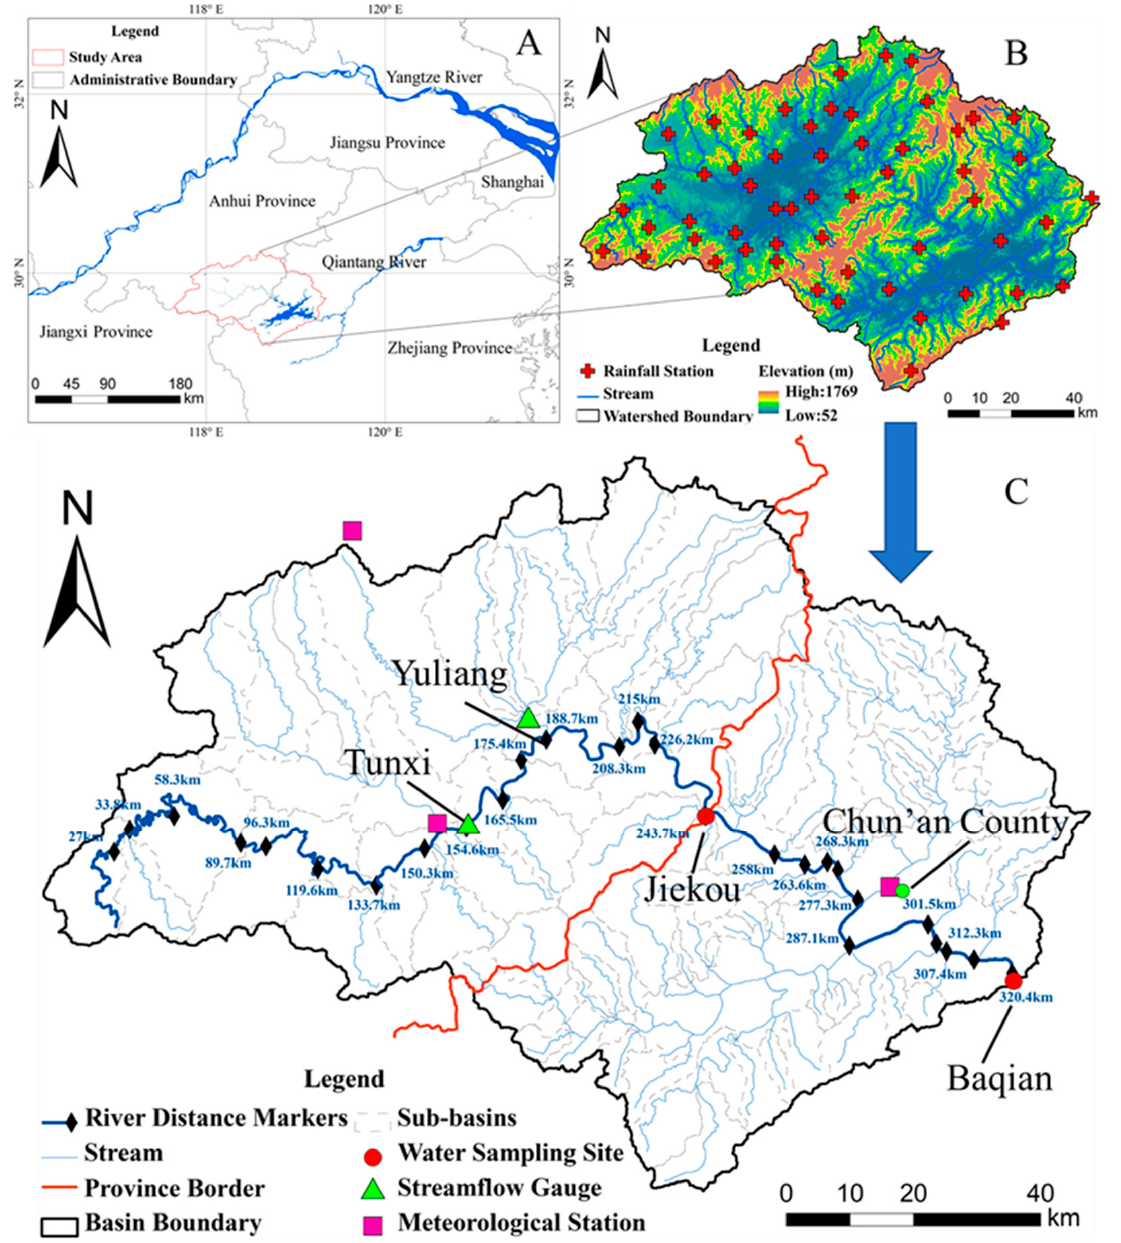
Figure 1. The Qiandao Lake Basin (QLB). ( A ) The Yangtze River delta region showing the orientation of the basin in Anhui and Zhejiang provinces. ( B ) Topography of the basin showing elevations and the location of rainfall stations. ( C ) Detailed map of the basin showing streams, sub-basins, important monitoring sites, and distance markers along the reach of the Xin’anjiang River. The location of the urban core of Chun’an County is also given.